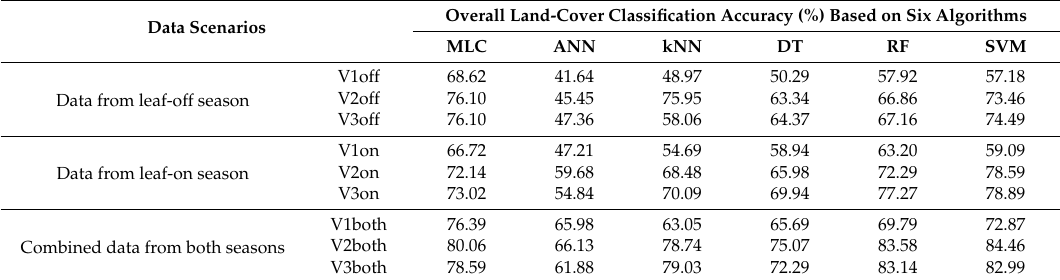
Table 5. Summary of overall accuracies of all land-cover classes among six classification algorithms based on different data